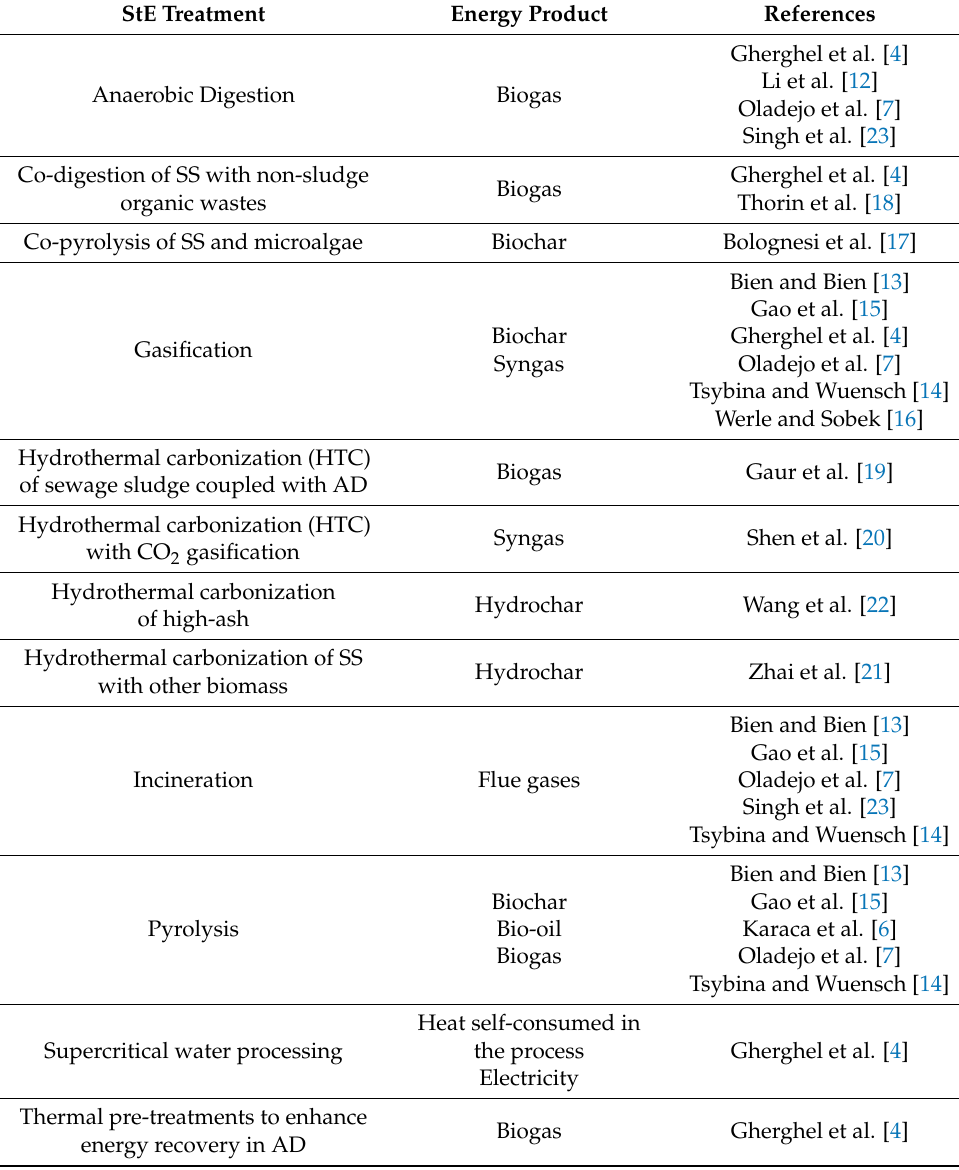
Table 1. Summary of the sludge-to-energy (StE)